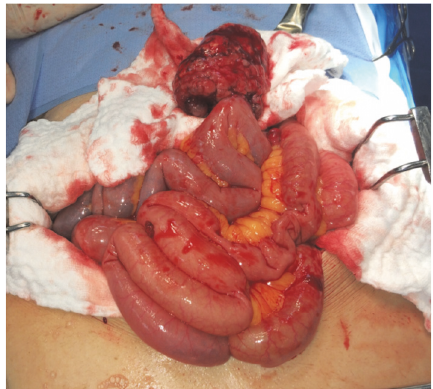
Figure 4: At laparotomy, a hypervascular calcified mass of 8 cm arising from the distal ileum, with ongoing intraluminal